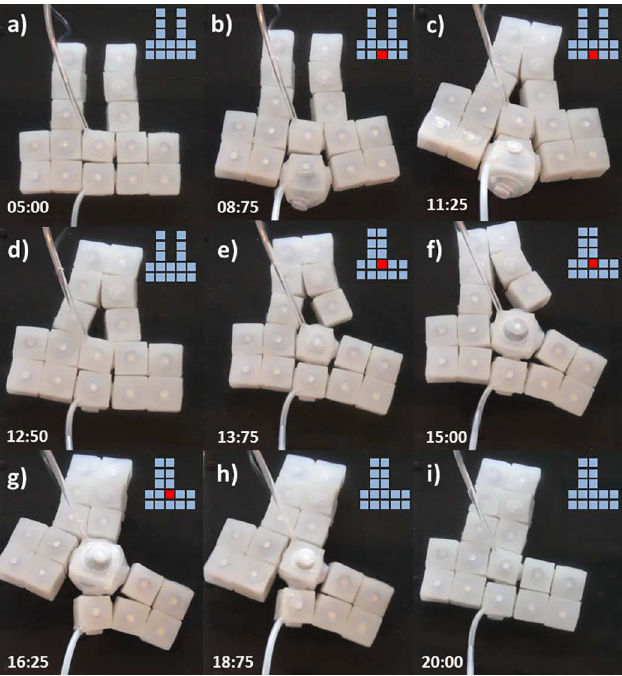
Fig 11. Self-Reconfiguration on setup 2A-14U. Demonstrationof self-reconfiguration on a group of 16 modulessubmerged in water. Initially a lower-center module is inflated (b) resultingin the closingof the ‘C’. Subsequently the moduledeactivates(d). Then the upper-centermoduleactivates (e) and deactivates(h) resulting in the new stable ‘T’ shape (i). Time stamps are in the format seconds:centiseconds.